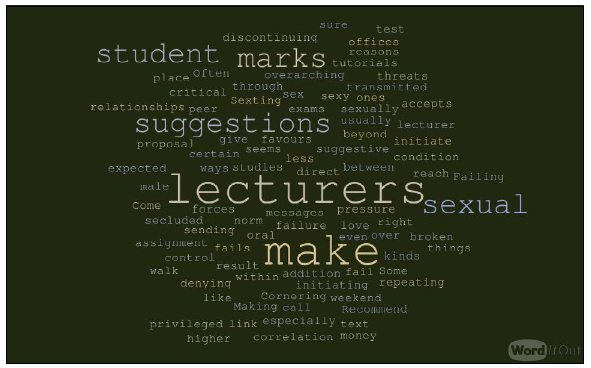
Figure 7: Word cloud generated from the responses, depicting two themes: ‘Students make sexual suggestions to lecturers via ‘sexting’ for marks for fear of failing’ or ‘Lecturers make sexual suggestions to students in return for